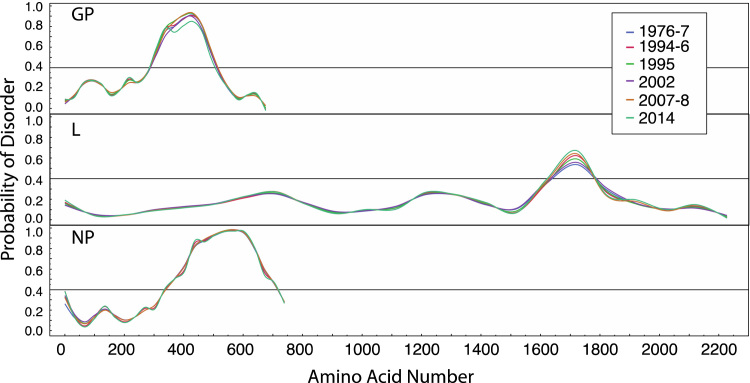
Prediction of disorder for GP, L and NP for sequences from each outbreak. Predictions were made with IUPred (Dosztanyi et al., 2005). The recommended cut off (0.4) for considering protein regions disordered is indicated.